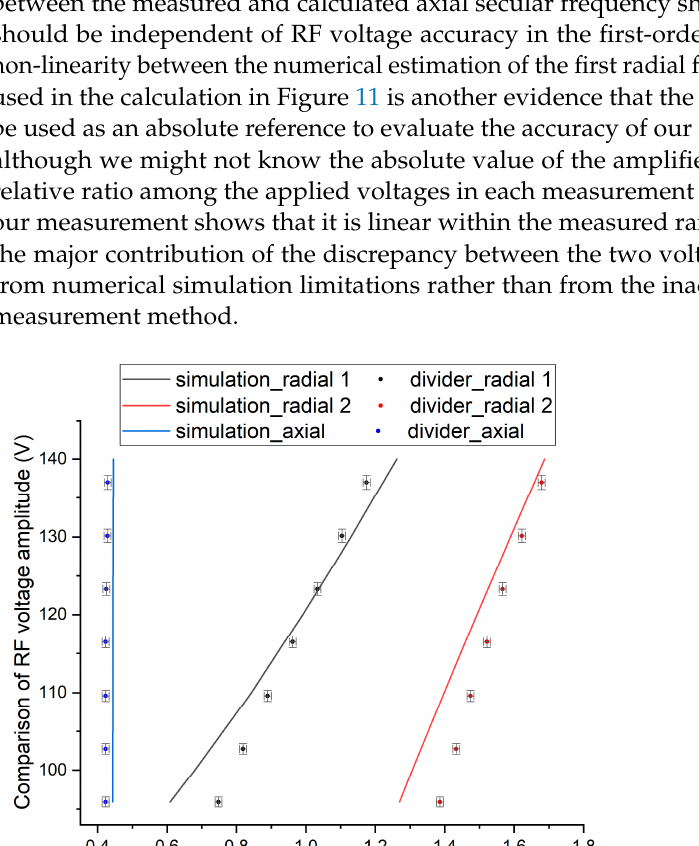
Figure 11. A comparison of RF voltage measured by the voltage divider with the estimated voltage necessary to obtain the same secular frequencies based on the numerical simulation. The relation between estimated voltage and expected secular frequencies comes from Figure 4.